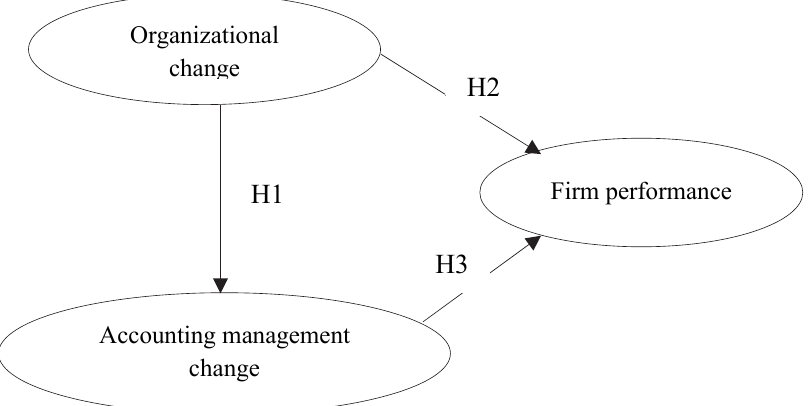
Fig. 1. The proposed